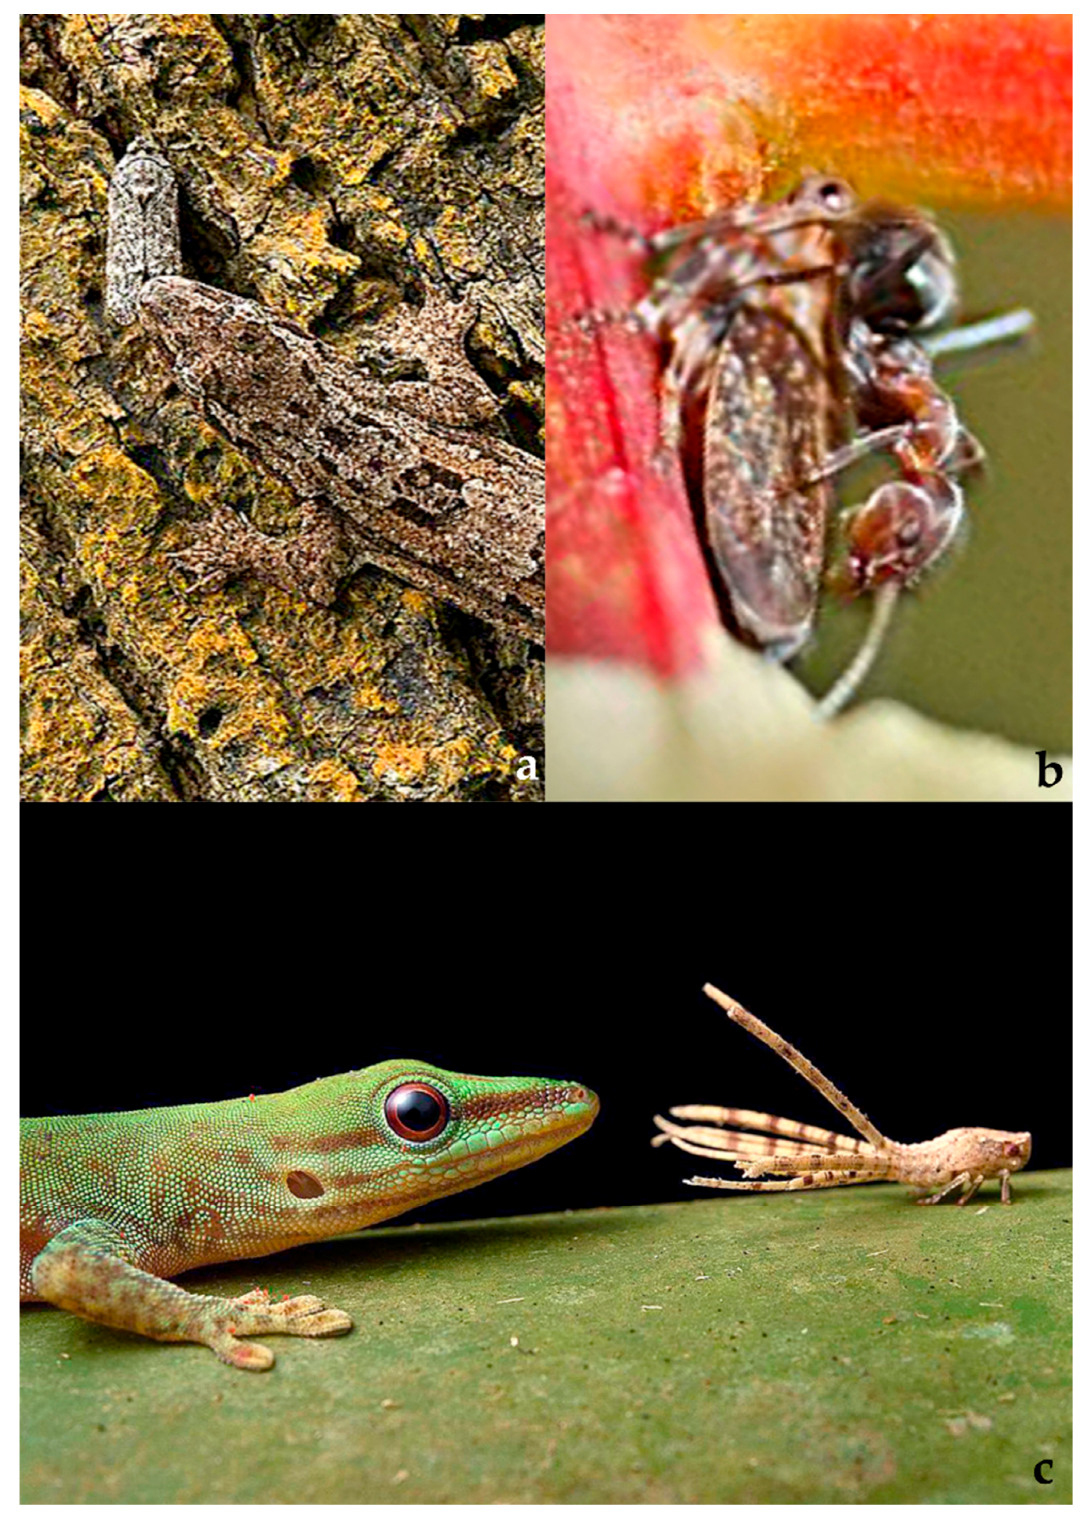
Figure 36. Unidentified Fulgoromorpha: ( a ) Probably Cixiidae tended by Reptilia: Squamata: Gekkonidae: Hemidactylus craspedotus Mocquard, 1890, Malaysia: Sabah, Sepilok, 5°50 ′ 21.8 ″ N 117°56 ′ 57.2 ″ E, 20.09.2018, adult on tree trunk, obs. C. Lee; ( b ) Issidae tended by Formicidae indet., Australia: Queensland, Roma, 26°34 ′ 29.7 ″ S 148°48 ′ 30.0 ″ E, adult, obs. “tjeales”; ( c ) Ricaniidae or Flatidae nymph tended by Reptilia: Squamata: Gekkonidae: Phelsuma guttata Kaudern, 1922, Madagascar: Marojeji National Park, 14°26 ′ 14.9 ″ S 49°46 ′ 32.3 ″ E, 21.10.2016, adult, obs. C. Lee.